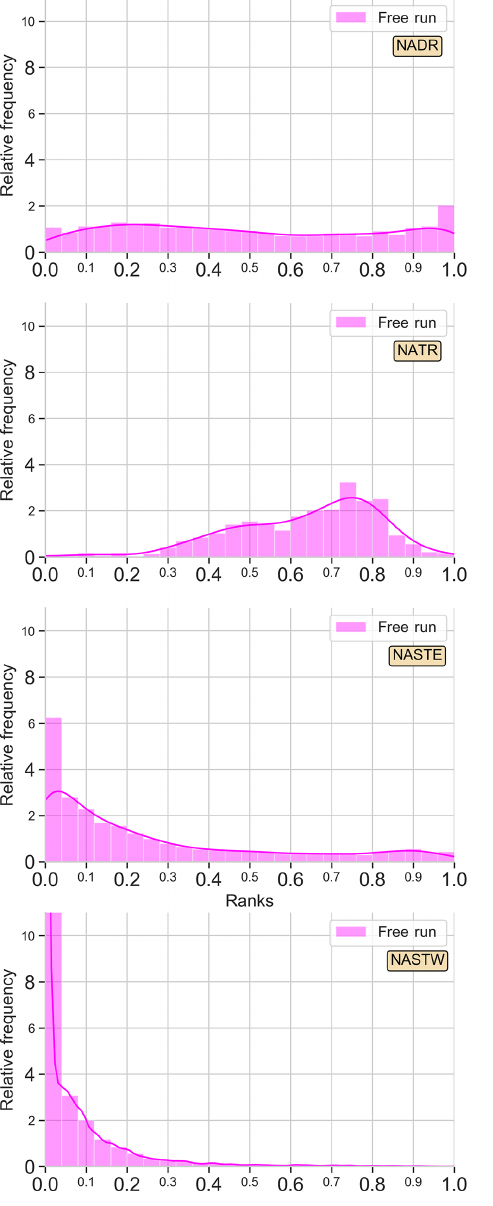
Figure 3. Surface Chl a rank histograms of the 24-member free-run experiment (magenta; left panels) and the 24-member analysis ensemble assimilation experiment (light green: right panels) in comparison with SeaWiFS data for 15 May 2005. A 30% SeaWiFS observation error is taken into account. Longhurst provinces NADR, NATR, NASTE, and NASTW are represented.